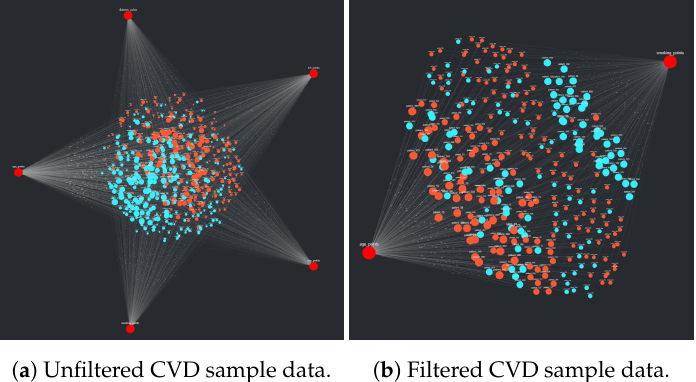
Figure 13. The CVD sample data, both unfiltered ( a ) and filtered ( b ), based on criteria described in Section